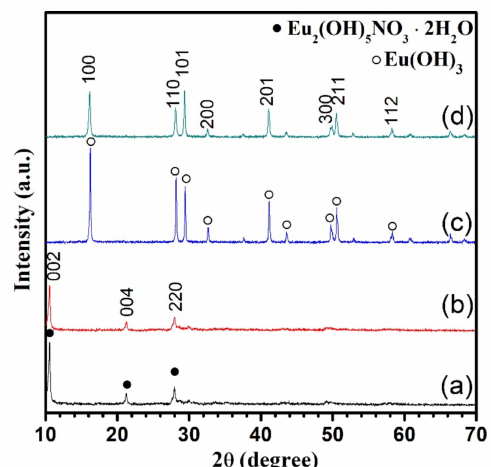
Figure 1. XRD patterns of the products obtained at 80 ◦ C for 24 h as a function of the pH value of the starting solution. The pH value used is 7.34 ( a ), 9.24 ( b ), 10.82 ( c ), 12 ( d